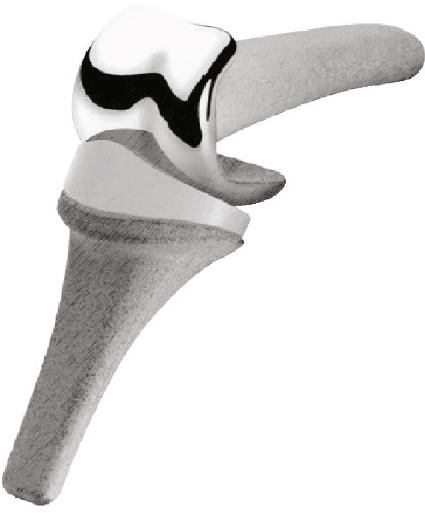
Figure 6: MatOrtho PIP fi nger joint